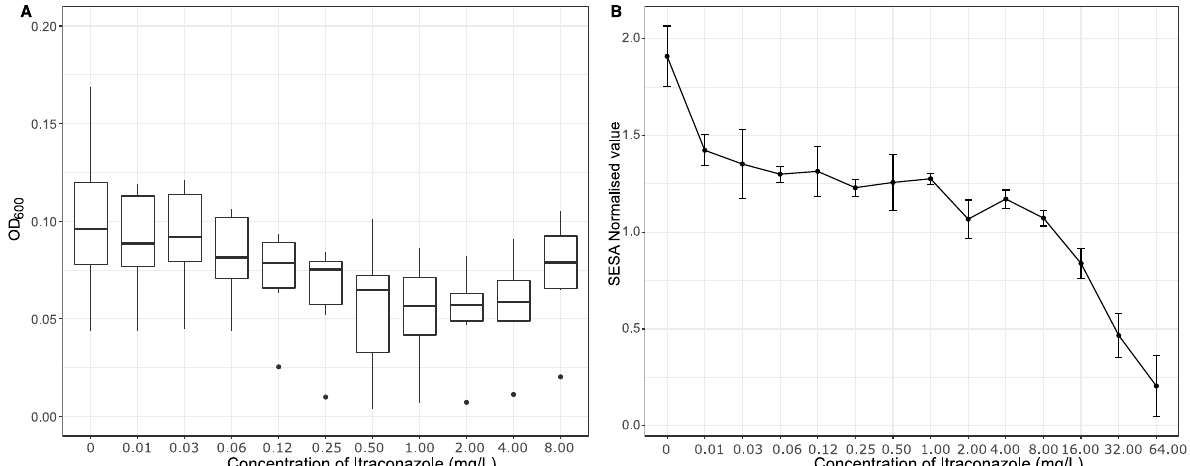
Figure 3. ( A ) The average optical density (OD 600 ) showing the amount of growth from six isolates of Aspergillus niger potentially displaying paradoxical resistance. The OD 600 was read after two days of incubation with varying concentrations (0–8.0 mg/L) of itraconazole. The boxplots bound the interquartile range (IQR) divided by the median; the whiskers extend to 1.5 × IQR beyond the box. Single points are used to indicate potential outliers. ( B ) Segmentation Extraction Surface Area (SESA) ‐ normalised values measured after 48 h, showing the biomass produced by a single isolate of Aspergillus niger challenged with concentrations of itraconazole ranging from 0 to 64.0 mg/L.